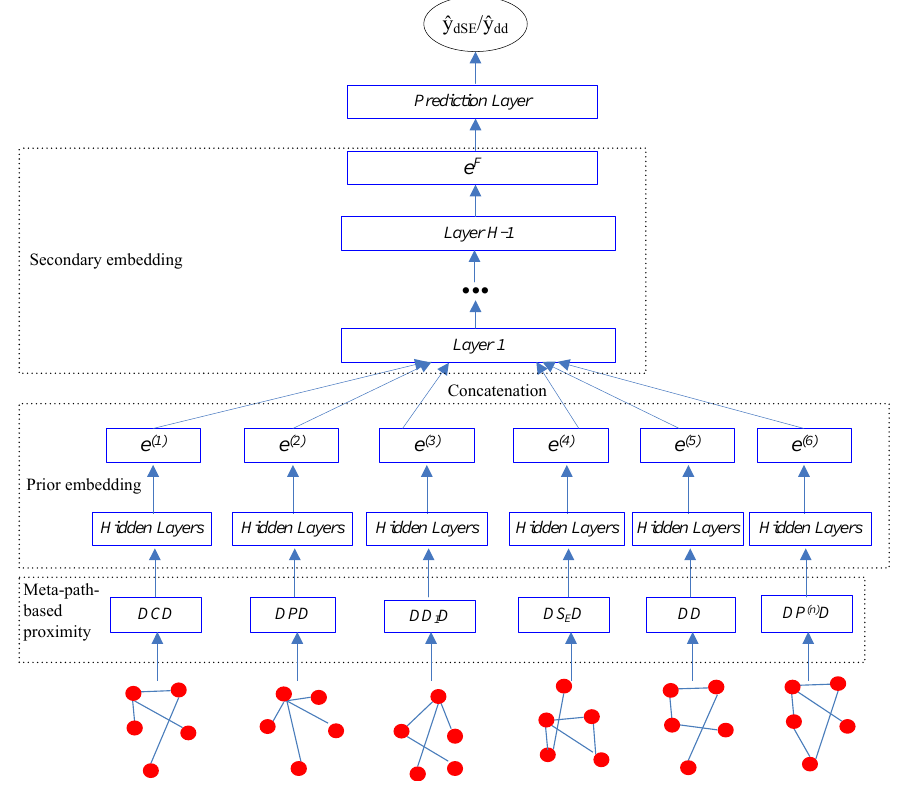
Figure 5. The framework of our proposed semi-supervised deep model